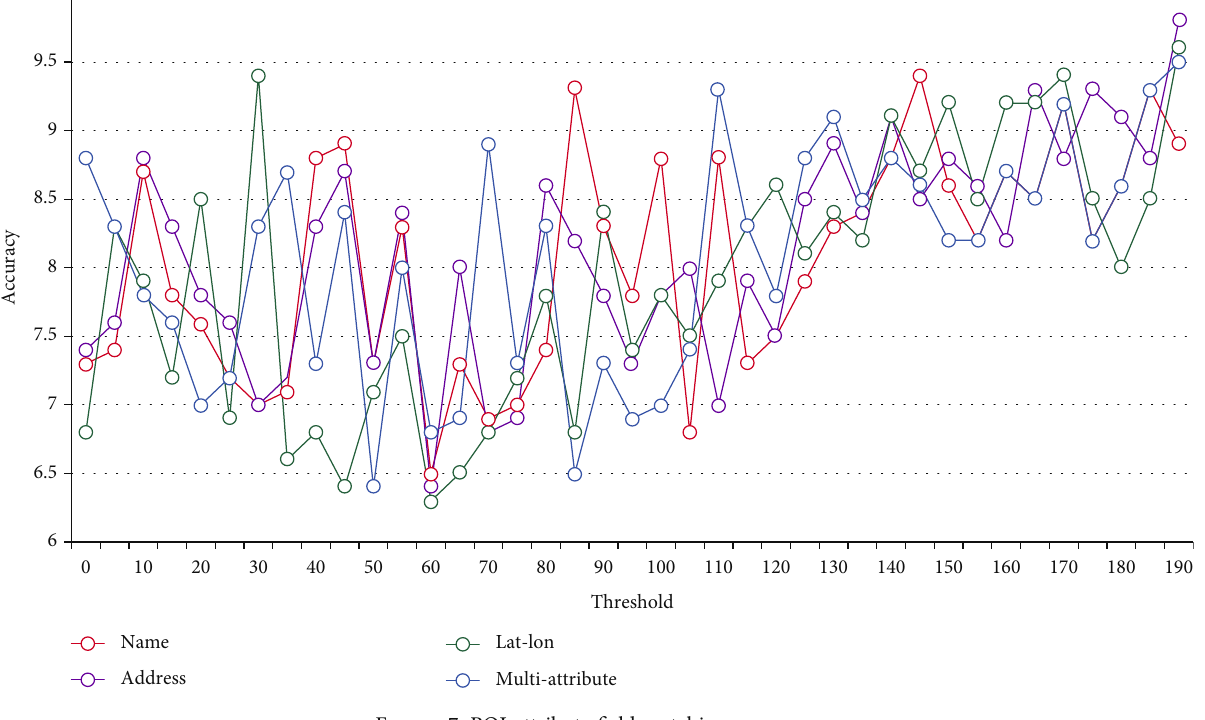
Figure 7: POI attribute fi eld matching accuracy.